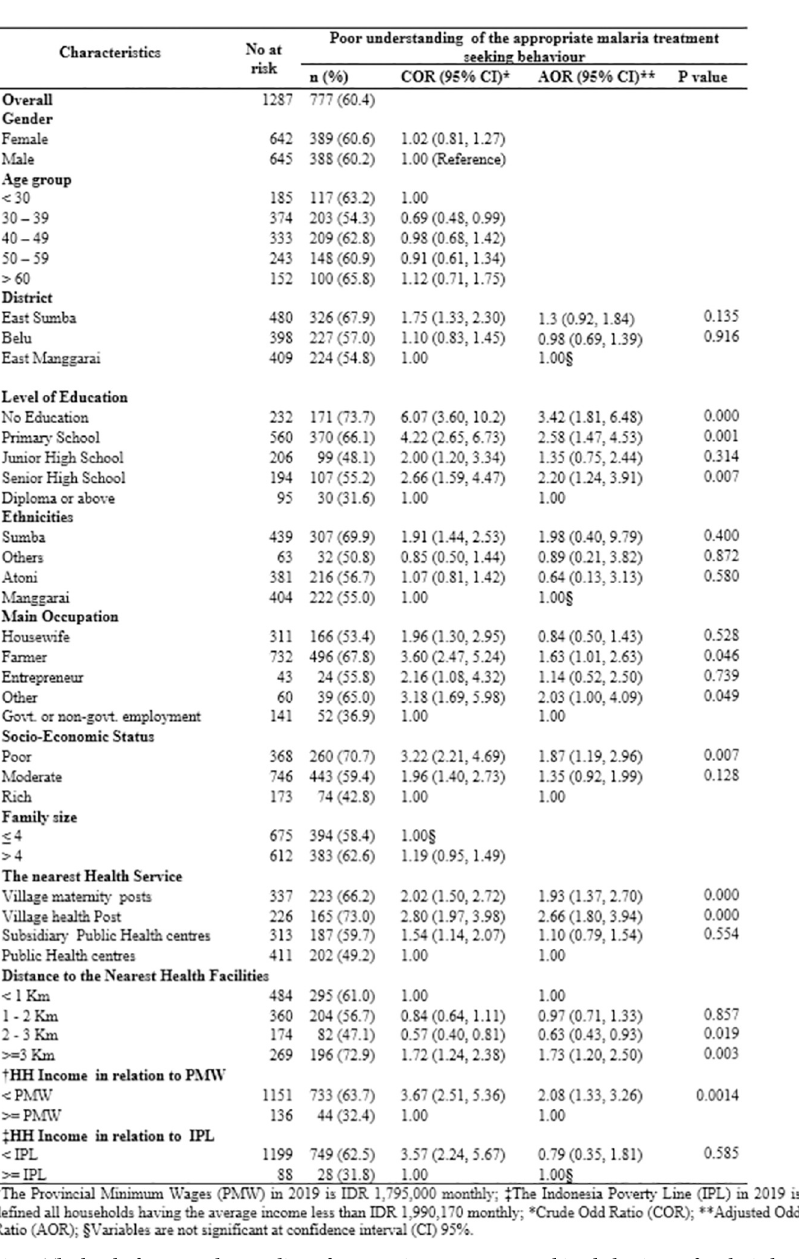
Fig 4. The level of poor understanding of appropriate treatment-seeking behaviour of malaria by different sociodemographic and environmental characteristics in the East Nusa Tenggara Province, Indonesia (n = 777).